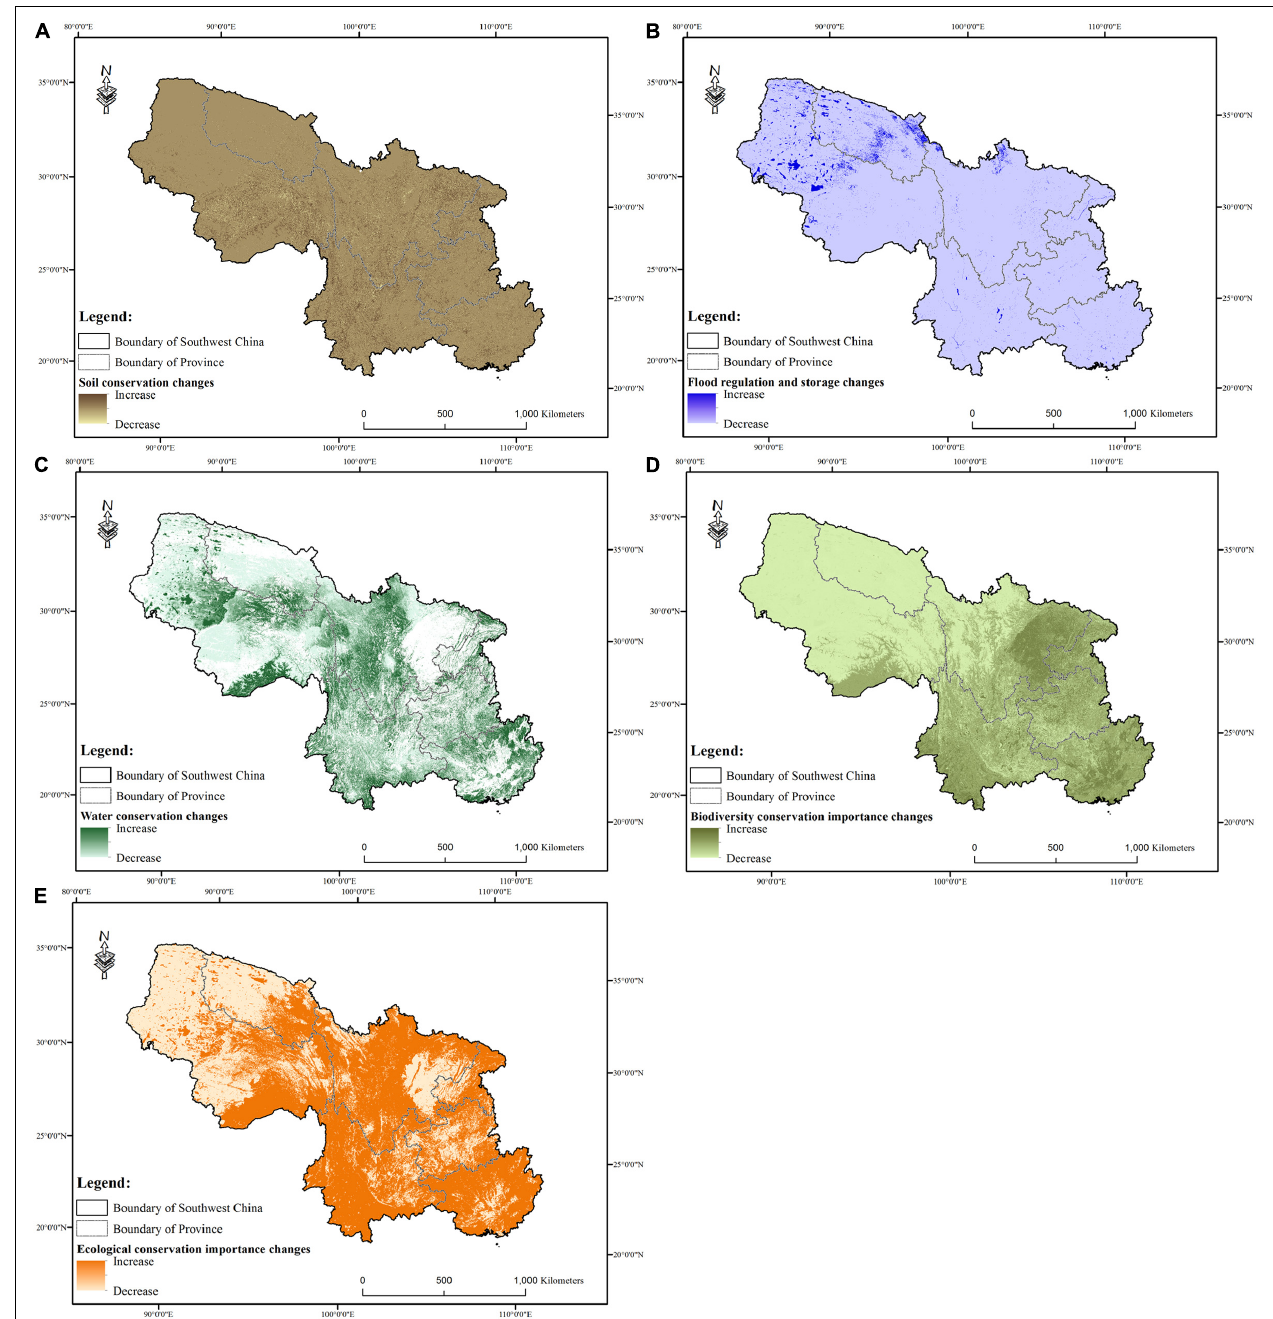
FIGURE 5 | Soil conservation (A) , flood regulation and storage (B) , water conservation (C) , biodiversity conservation importance (D) , and ecological conservation importance changes (E) in Southwest China during the study